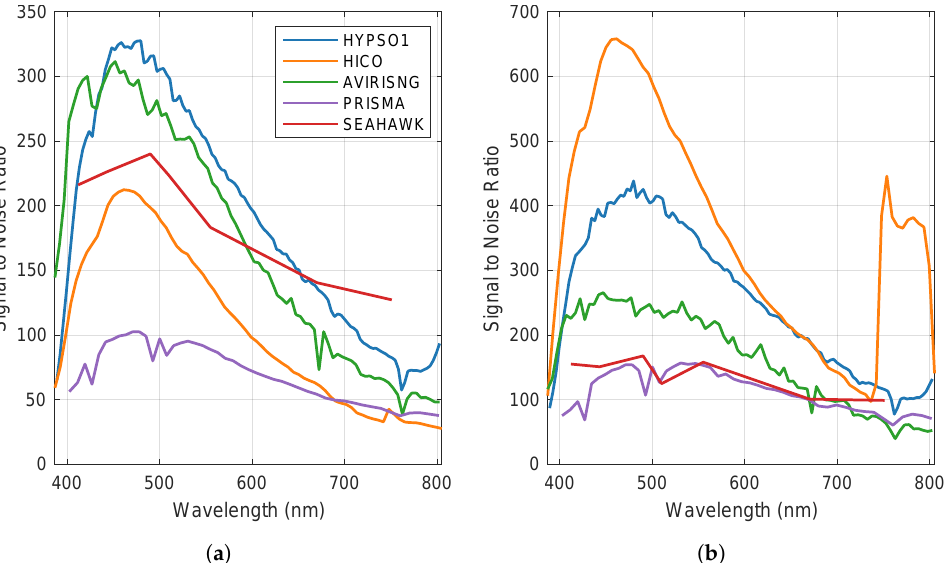
Figure 16. SNR estimates of sensor read-outs with two different approaches. The spectral approach estimates noise by the difference between the estimated spectral value as a linear regression between neighboring bands and the measured value. The spatial approach estimates noise by the variance between spatially neighboring pixels. Note that the y -axis is different for the two figures. ( a ) Spatial noise estimation [50]; ( b ) spectral noise estimation